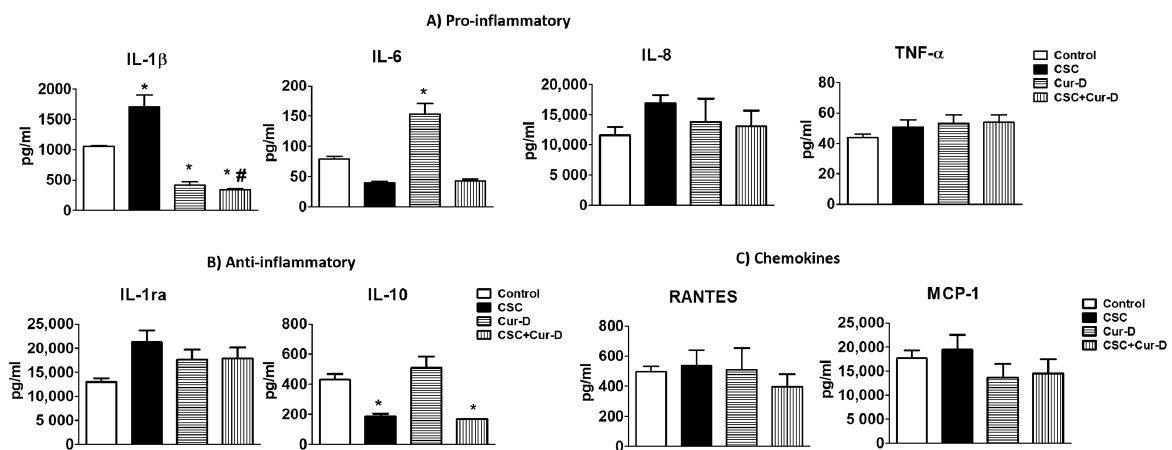
Figure 9. Measurement of cytokines in U1-cell media treated with CSC and Cur-D across the BBB model: The upper inserts containing endothelial cells were exposed to a single dose of Control (DMSO), CSC (40 µg/mL), and Cur-D (0.4 µM) and observed for 3 days. The protein levels of various cytokines and chemokines were measured from the culture media of the bottom chamber containing differentiated U1 macrophages using Human Custom Procartaplex 8-plex. One-way ANOVA with Tukey’s post-hoc test was applied to compare between multiple groups. * represents p < 0.05 when compared with control. # represents p < 0.05 when compared with CSC.